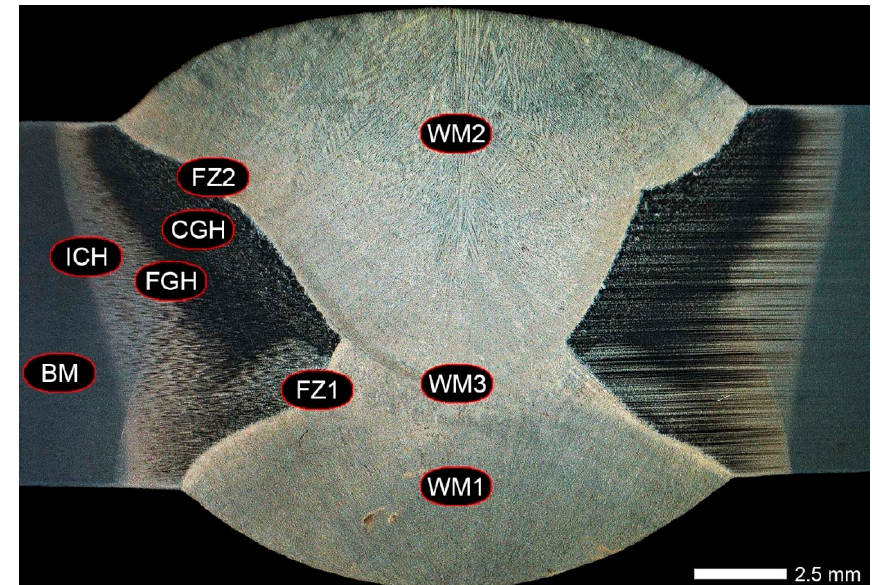
Figure 5. Macroscopic image of cross-section of a Hardox Extreme welded joint after welding. WM— weld metal zone, FZ—fusion zone, BM—base material zone, CGH(AZ)—coarse-grained heat-affected zone (overheating), FGH(AZ)—fine-grained heat-affected zone (normalization and recrystallisation), ICH(AZ)—intercritical heat-affected zone (incomplete normalization). Stereoscopic microscopy, etched with 3% HNO3 and Adler’s etchant.